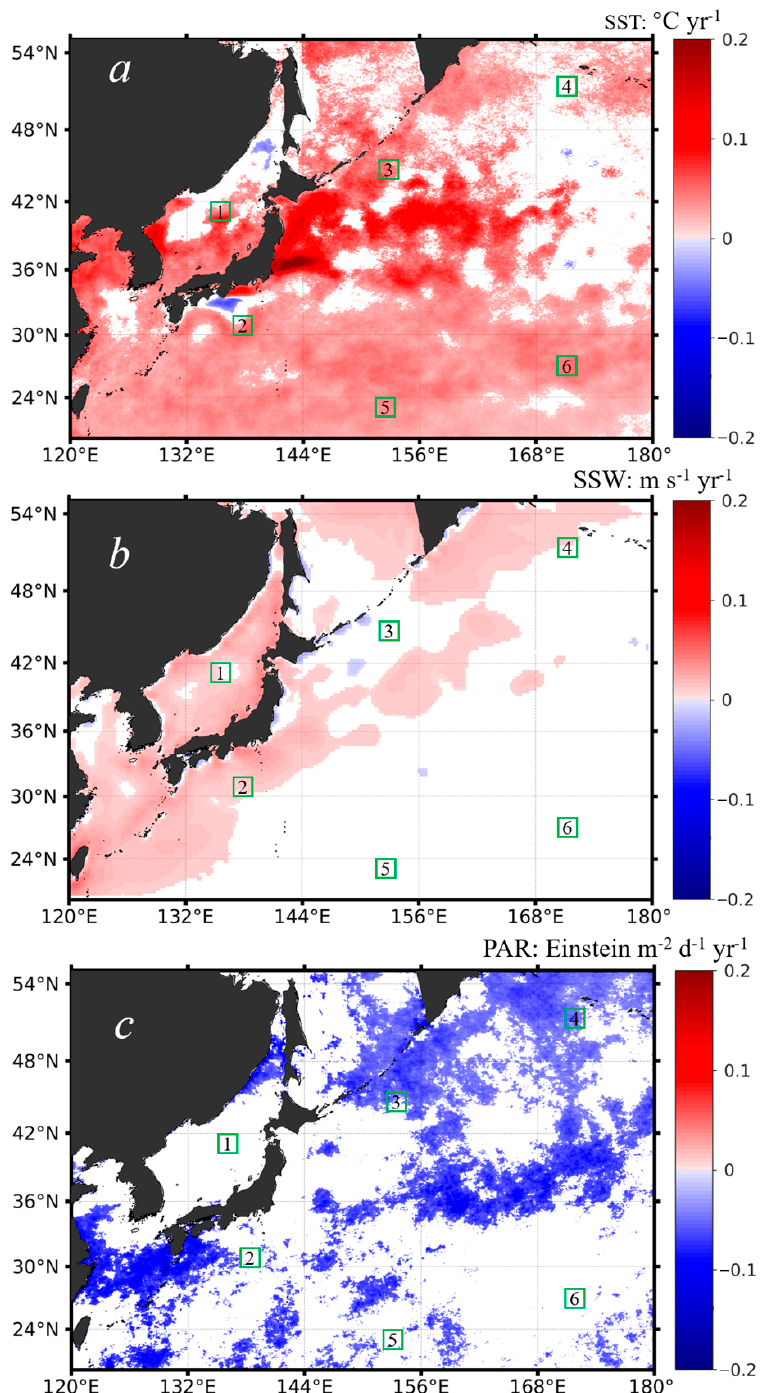
Figure 7. The spatial distribution of the interannual changing rates of different environmental variables including SST ( a ), SSW ( b ), and PAR ( c ) in the northwest Pacific, based on the monthly data anomalies in the period of 1997–2020, with warm colors suggesting positive trends and cold colors suggesting negative trends. Note that only statistics at the significance level (i.e., p < 0.05) were shown; the areas in white mean that the variable had no significant trends in the study period. The six subregions outlined in a 2 ◦ × 2 ◦ box (i.e., boxes of 1–6 outlined in green) are the same as those shown in Figure